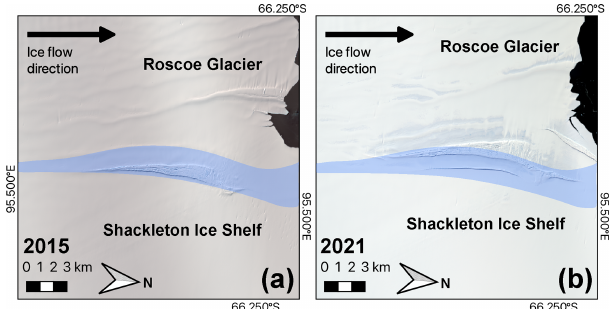
Figure 5. Rift opening in the vicinity of the shear margin between the Shackleton Ice Shelf and Roscoe Glacier (location marked in blue) between (a) 2015 (background: Landsat 8 OLI acquired on 14 March 2015) and (b) 2021 (Sentinel 2B acquired on 13 February